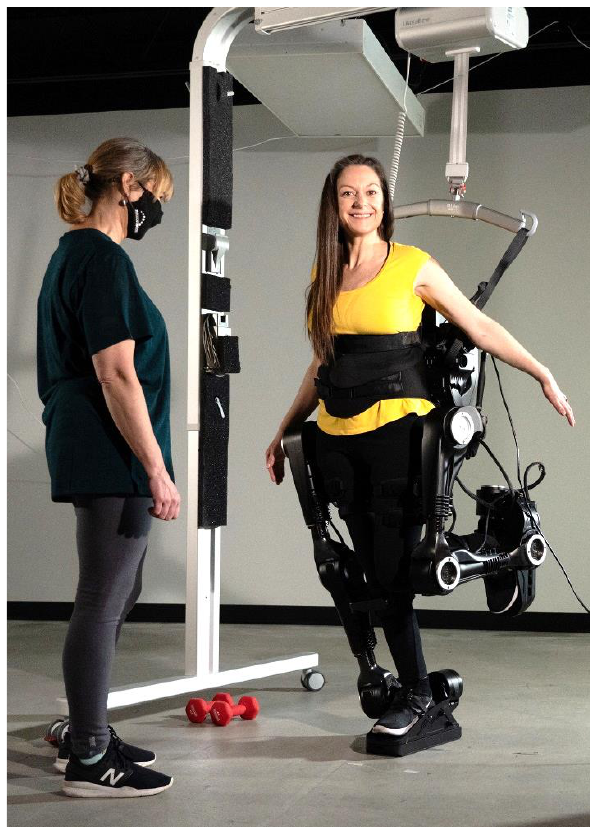
Figure 3: Myself, wearing the first-generation prototype of the Human in Motion Exoskeleton, standing on one leg independently. The harness is there just for safety, it is not supporting